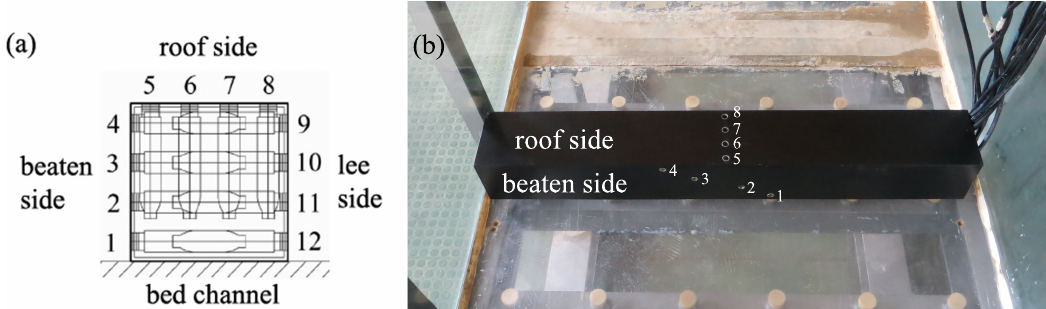
Figure 2. ( a ) Representative cross-section of the pressure transducers at the barrier; ( b ) Detail of the installation in the wave flume of the pressure transducers at the barrier from the beaten